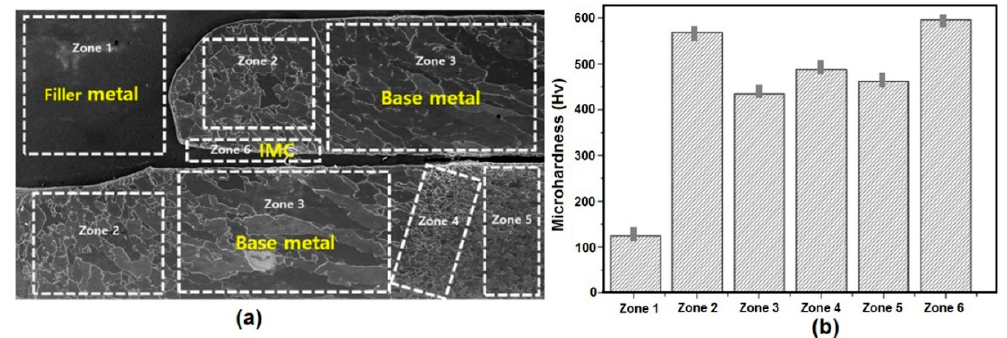
Figure 9. ( a ) The section for microhardness measurements. ( b ) Microhardness of the cross-section (80 cm / min, 70 A).